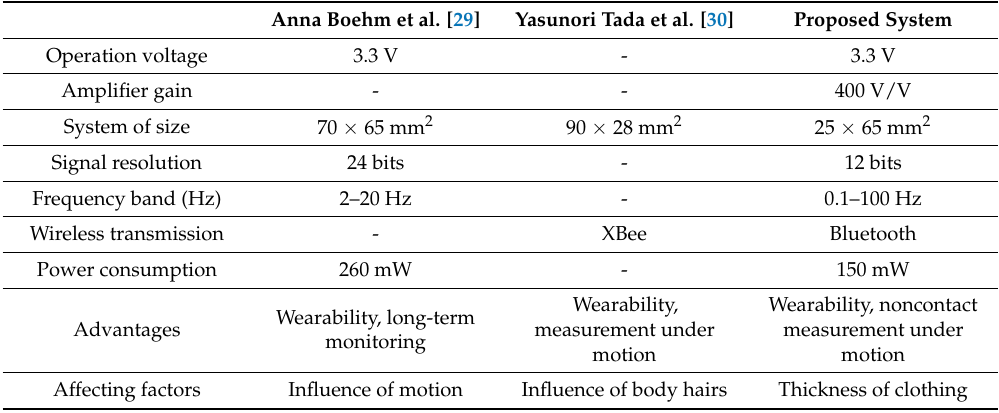
Table 2. The specification comparisons between the proposed 12-Lead ECG monitoring system and other